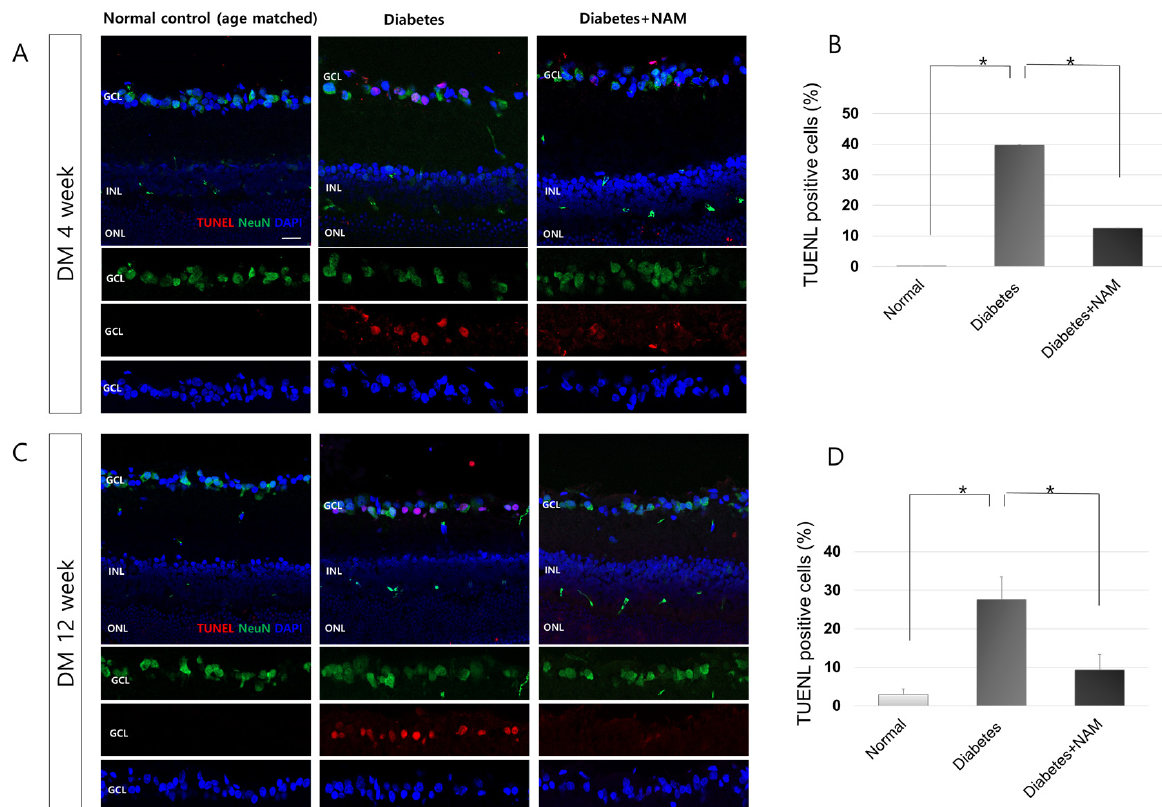
Figure 8. Apoptosis in the diabetic retina. Terminal deoxynucleotidyl transferase-mediated dUTP nick-end labeling (TUNEL)-positive cells were observed in the ganglion cell layer (GCL) and colocalized with anti-NeuN antibody at 4 and 12 weeks after induction of diabetes (A, C). The percentage of TUNEL-positive cells was higher in diabetic retinas than in the normal control ( p = 0.002, p < 0.001) at 4 and 12 weeks, respectively, after onset of diabetes (B, D). The proportion of apoptotic cells in diabetic retinas was reduced by administration of nicotinamide at 4 and 12 weeks after induction of diabetes ( p = 0.002, p < 0.001, respectively). Scale bar = 20 µm . DM, diabetes mellitus; NAM, nicotinamide . INL, inner nuclear layer. ONL, outer nuclear layer. *, significantly different as indicated ( p < 0.05).